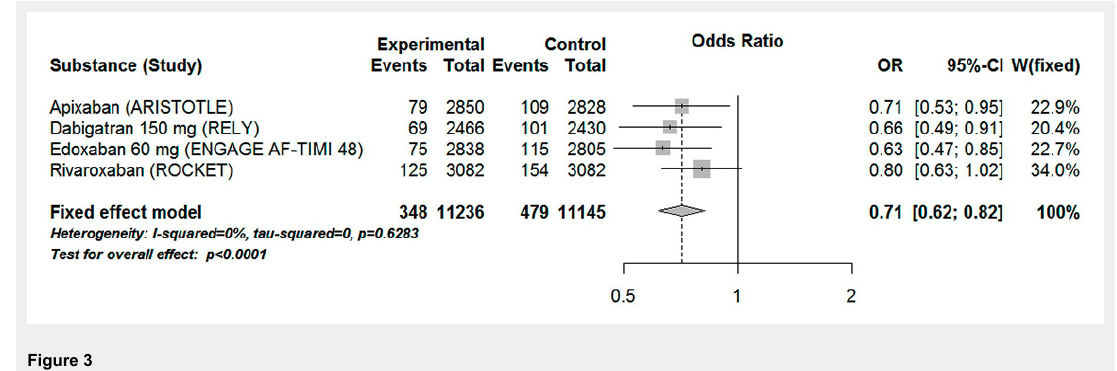
Figure 3 Forest plot of stroke or systemic embolism in patients with atrial fibrillation aged 75 years or over for analysis including high-dose dabigatran and edoxaban. CI = confidence interval; experimental = direct oral anticoagulants; control = vitamin K antagonists